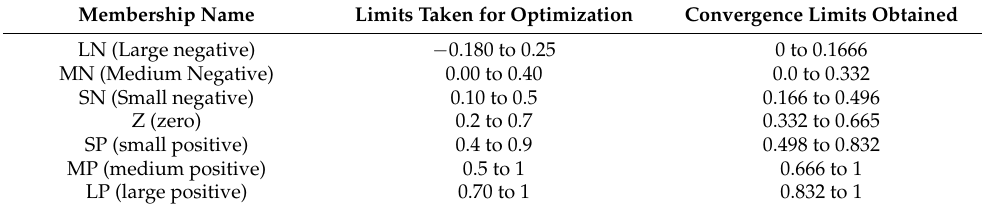
Table 4. Convergence results of fuzzy members’ limits obtained by